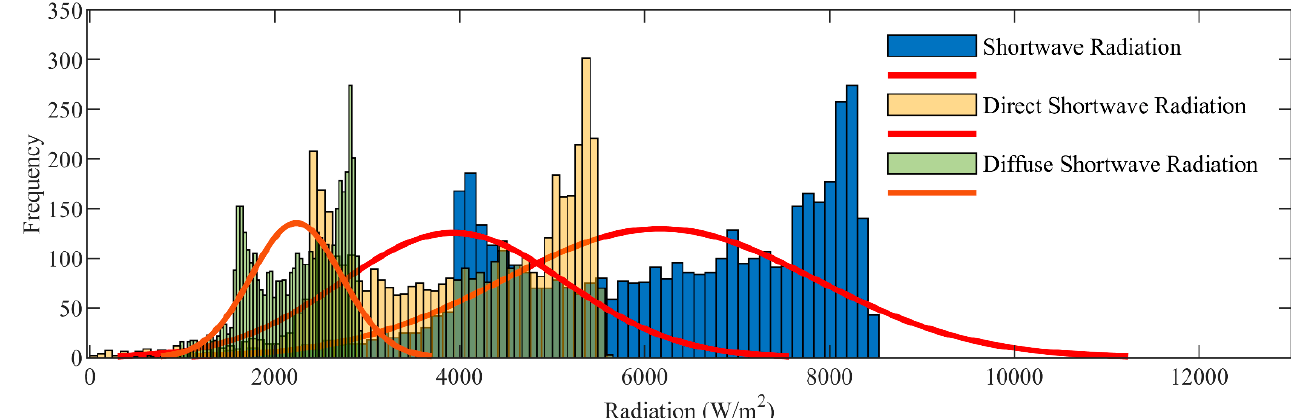
Figure 3. Sample data of solar irradiation used in this